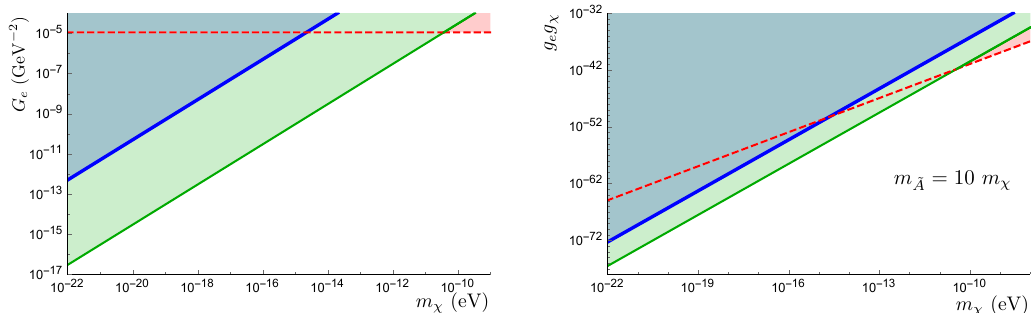
Figure 6 . Left: expected constraints on DM-electron coupling G e g e g χ /m 2 for the scalar ˜ A ≡ 0 . 1 GeV) from atomic clocks — thick-solid (blue) line —, DM case with a heavy mediator ( m ˜ A ≥ magnetometers — thin-solid (green) line —, and DM pair emission in stars — dashed (red) line. Right: expected bounds on the product of DM and electron couplings of the mediator ˜ A with mass = 10 m χ ; same line color coding, with the star cooling bound coming from ˜ A m ˜ A